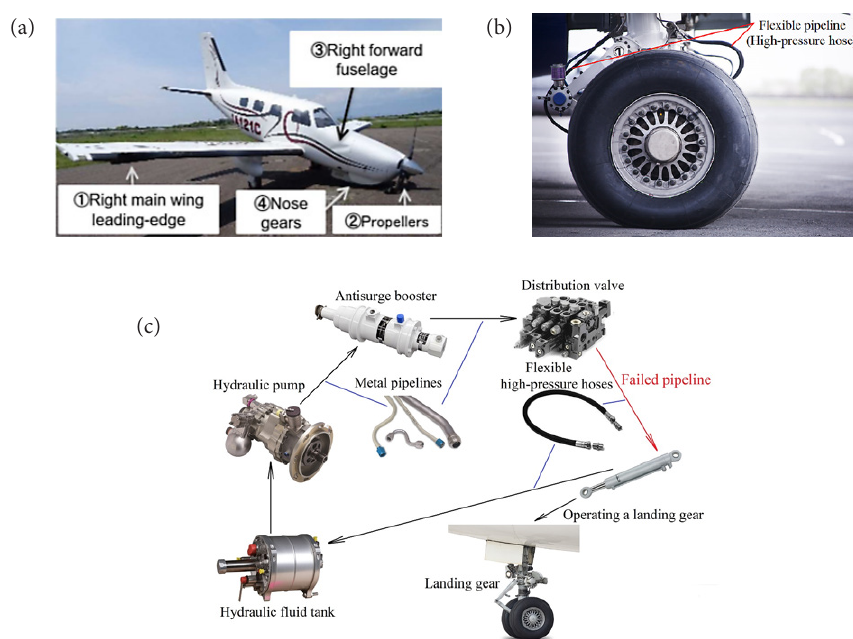
Figure 2. An aircraft pipelines failure: (a) – the accident during non-extended aeroplane landing gear (JTSB, 2020); what under a study with a main components (by red colour pointed a